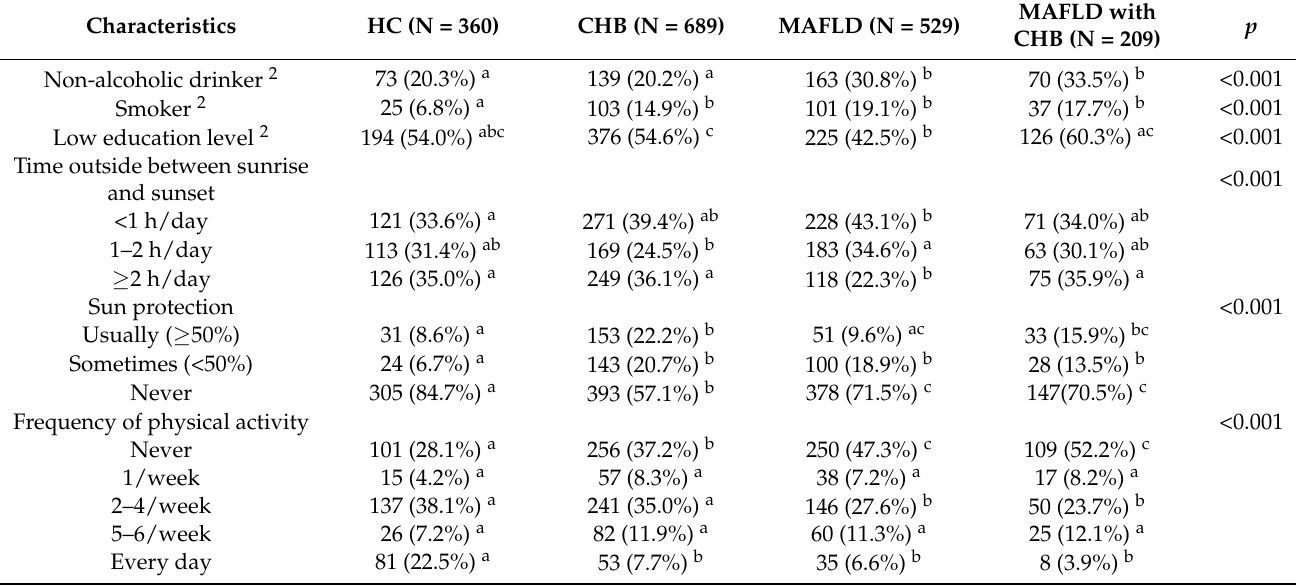
Table 2. Lifestyle characteristics of the population 1